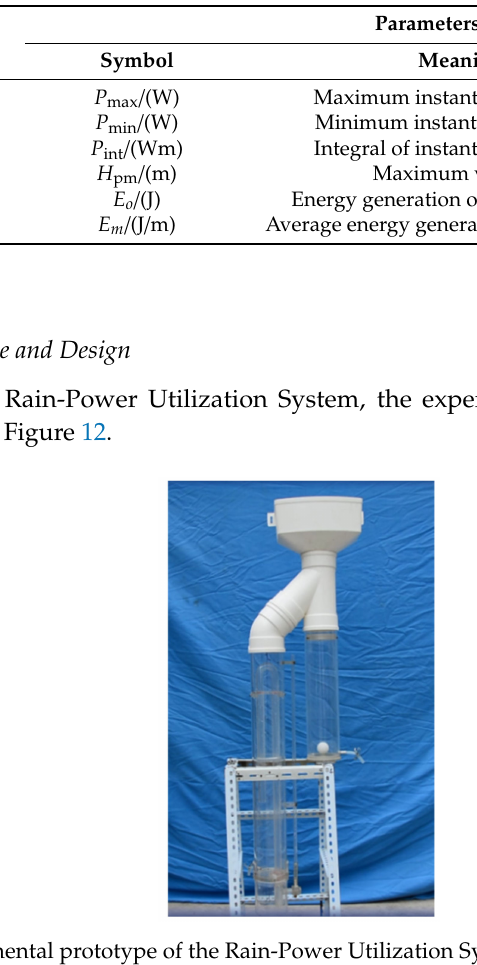
Figure 12. Experimental prototype of the Rain-Power Utilization System developed in